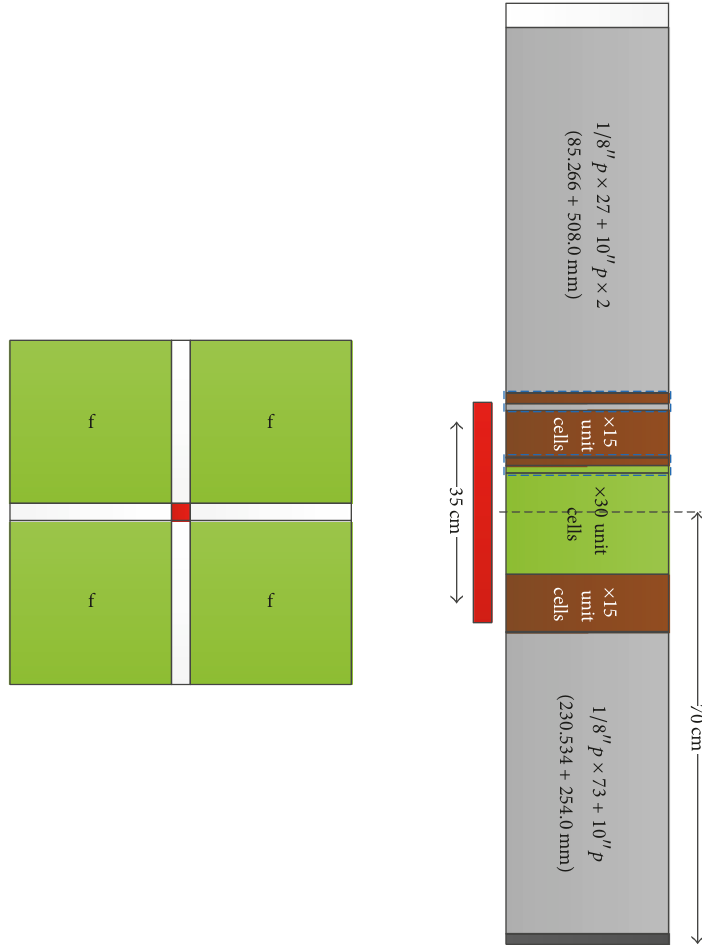
Figure 3: Tally region of the optical fiber detector (red region).